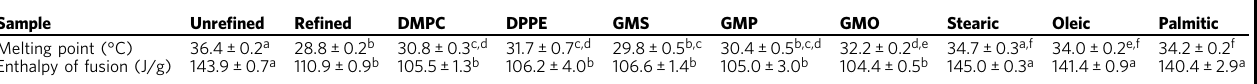
Table 1 Melting point and enthalpy of fusion of unre fi ned native CB, re fi ned CB, and re fi ned CB with added minor lipidic components.